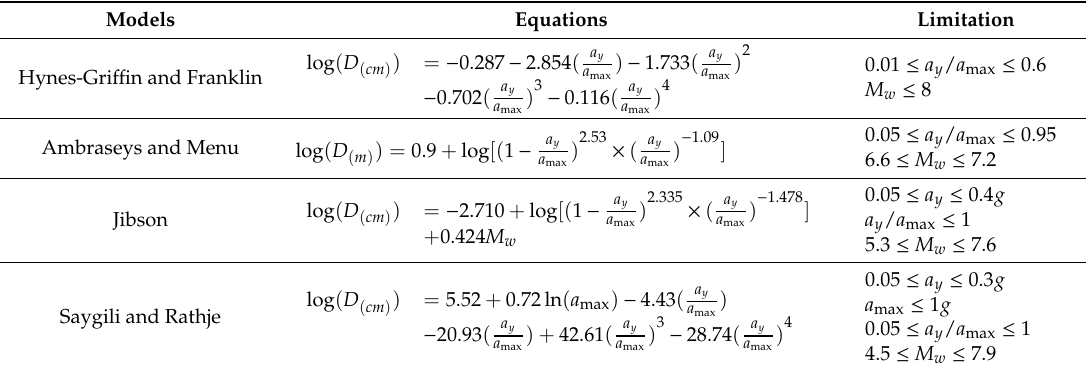
Table 7. The models developed for determining the value of slope deformation